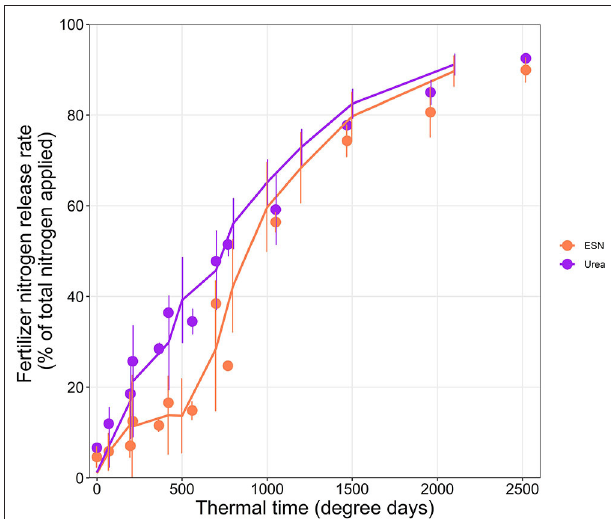
FIGURE 5 | Modeled (lines) and laboratory results (symbols) for nitrogen release with thermal time from urea and ESN applications. Modeled data (lines) were averaged for all the grid cells over the simulation period (January 1, 2011–December 31, 2015) for fall and spring banding across mid-slope landforms of Alberta under simulated barley cultivation. Error bars on modeled N release rates represent standard deviations of modeled N release rates due to variations in weather and soils. Observed laboratory results (symbols) were averaged for four treatments. Error bars on observed N release rates represent standard deviations of observed N release rates due to variations in moisture (section Validation and Analyses of Modeled